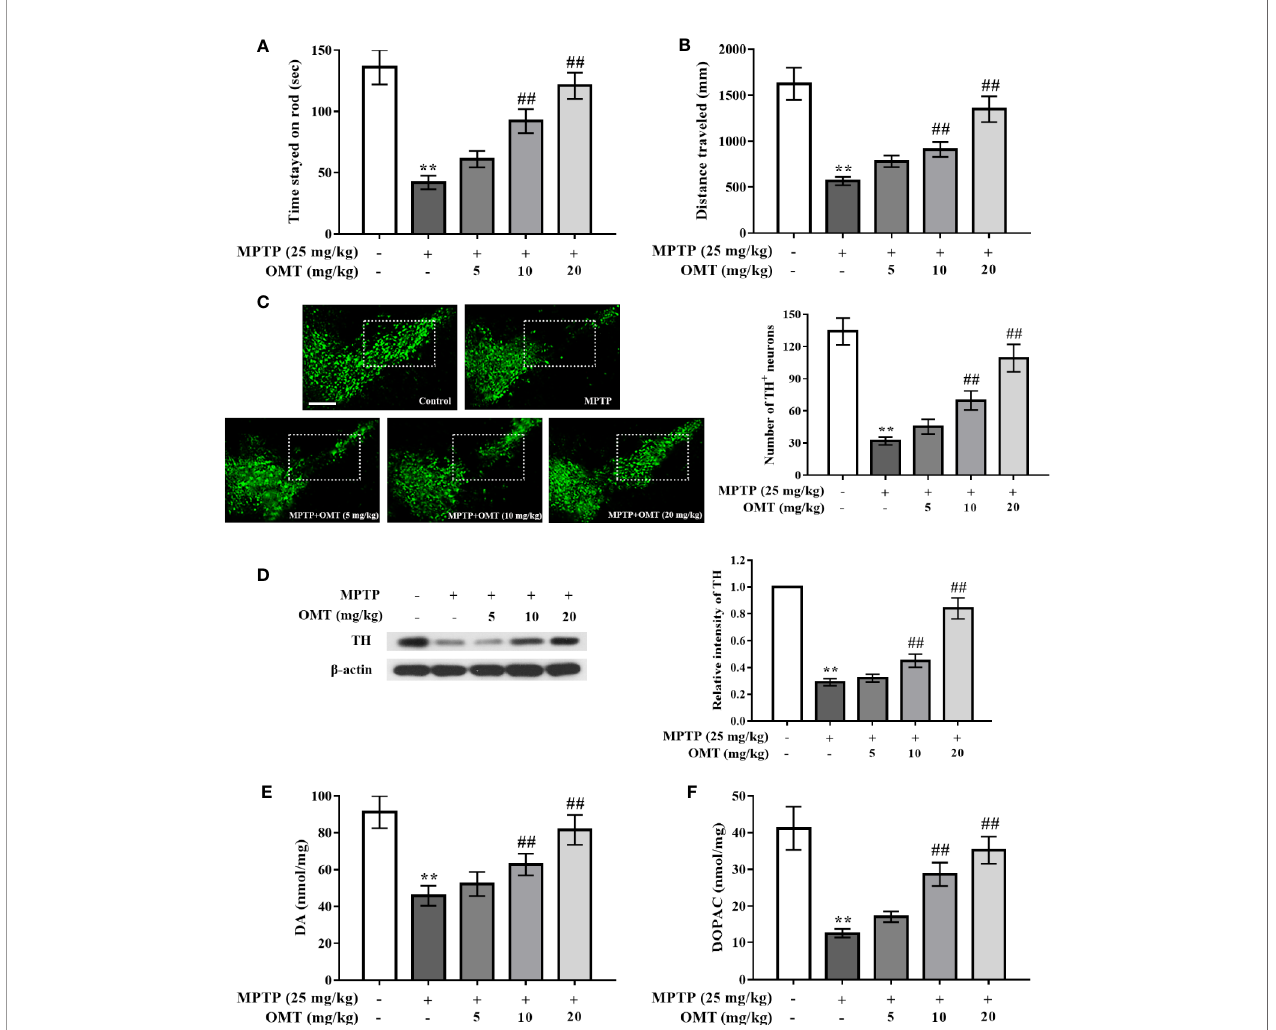
FIGURE 1 | Oxymatrine (OMT) attenuated 1-methyl-4-phenyl-1, 2, 3, 6-tetrahydropyridine (MPTP)-induced dopamine (DA) neuronal damage and alleviated motor de fi cits in Parkinson ’ s disease (PD) mice model. Mice were fi rst given a daily intraperitoneal injection (i.p.) of MPTP (25 mg/kg), followed by administration of OMT (i.p.) for 7 consecutive days. On day 8, rotarod test (A) and open- fi eld test (B) were performed. (C) Tyrosine hydroxylase (TH)-immunopositive (green) neurons in substantia nigra pars compacta (SNpc) area were detected by immuno fl uorescence staining. Scale bar: 200 m m. (D) The expression of TH in midbrain tissues was determined by Western blot analysis. (E , F) Changes in DA system in midbrain tissues of MPTP-induced mice. Levels of DA (E) and its metabolite dihydroxy-phenyl aceticacid (DOPAC) (F) in striatal homogenates of respective groups were tested by HPLC analysis. The data are presented as mean ± SEM. **p < 0.01 vs. Control group; ## p < 0.01 vs. MPTP group. ANOVA with Bonferroni ’ s post-hoc